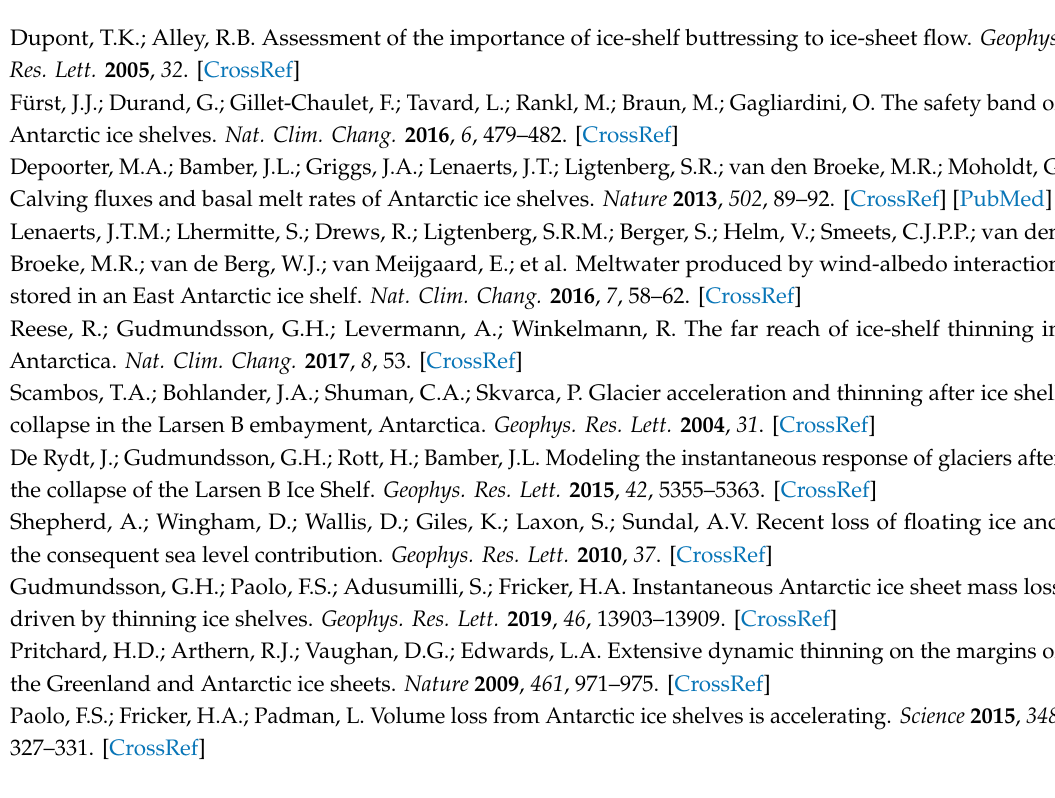
Figure A1. Landsat 8 and Sentinel-1 imagery showing the evolution of the largest calving event in 2016. The red dashed line shows the terminus position on 22 January 2017.